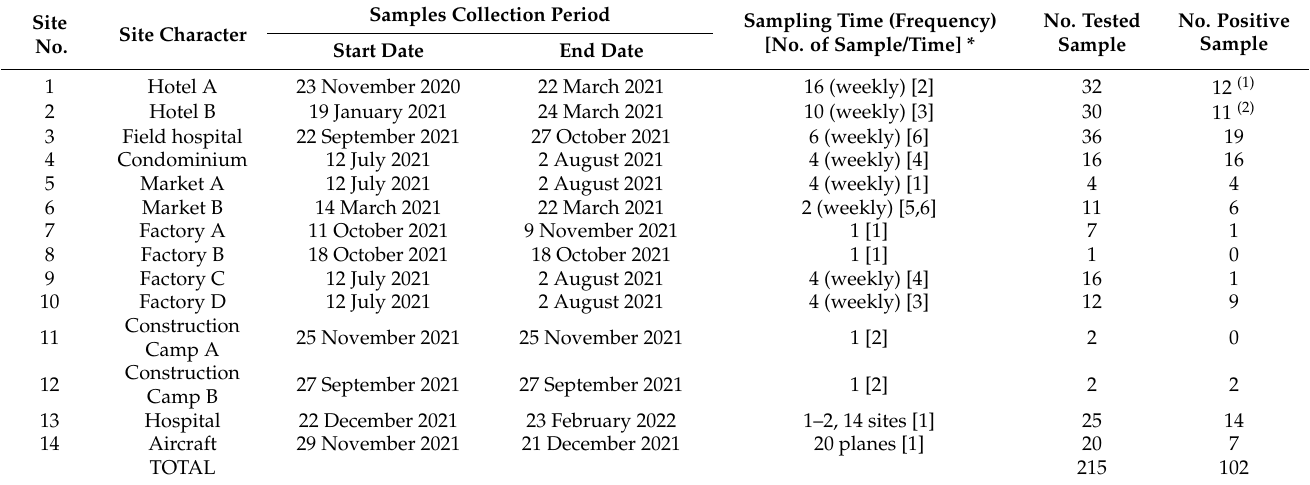
Table 1. Overview of sampling sites, sampling dates, number of sampling times and frequency, num- ber of samples collected each time, number of the SARS-CoV-2 RT-PCR-tested, and positive